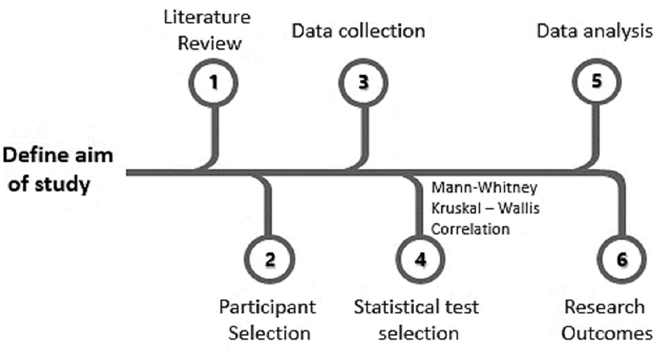
Figure2. The methodological process followed to develop the study.